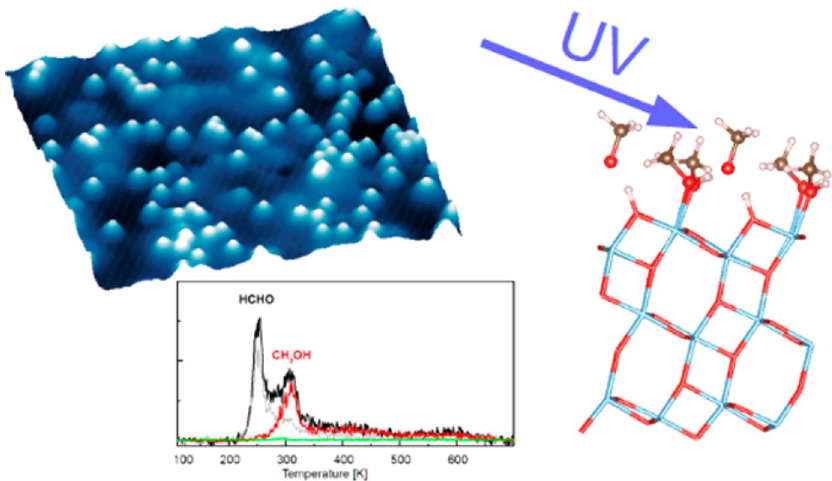
Figure 4. 3D STM image, ball-bond model applied in DFT, and TPD results relevant to CH 3 OH photocatalysis on anatase TiO 2 (101) (Reprinted figure with permission from [63] Copyright (2017) by the American Chemical Society).